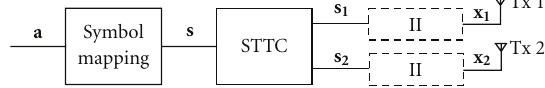
Figure 2: Signalling at the transmitter in Makai05